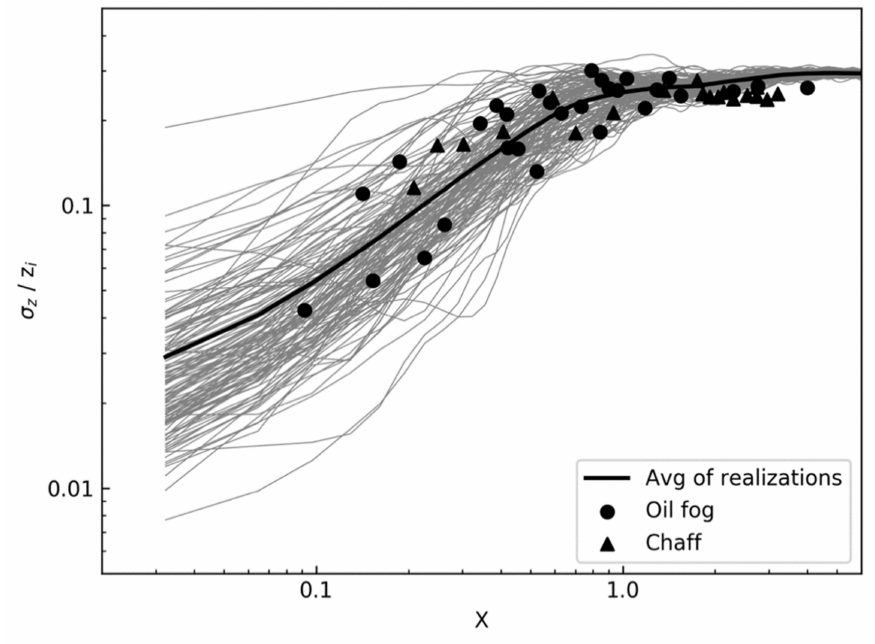
Figure 8. Normalized vertical dispersion as a function of the downwind distance. The gray lines depict 30 individual realizations from the LES model, while the black line represents the average of those realizations. The circles and triangles represent observations of normalized concentrations measured during the CONDORS